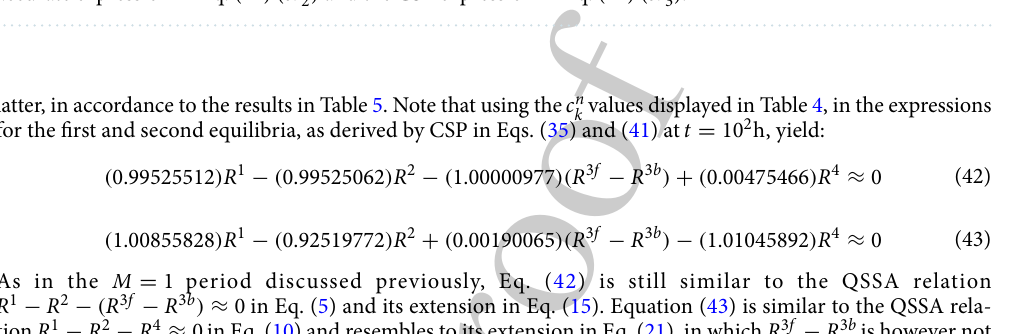
latter, in accordance to the results in Table 5. Note that using the c n k values displayed in Table 4, in the expressions for the first and second equilibria, as derived by CSP in Eqs. (35) and (41) at t = 10 2 h , yield: